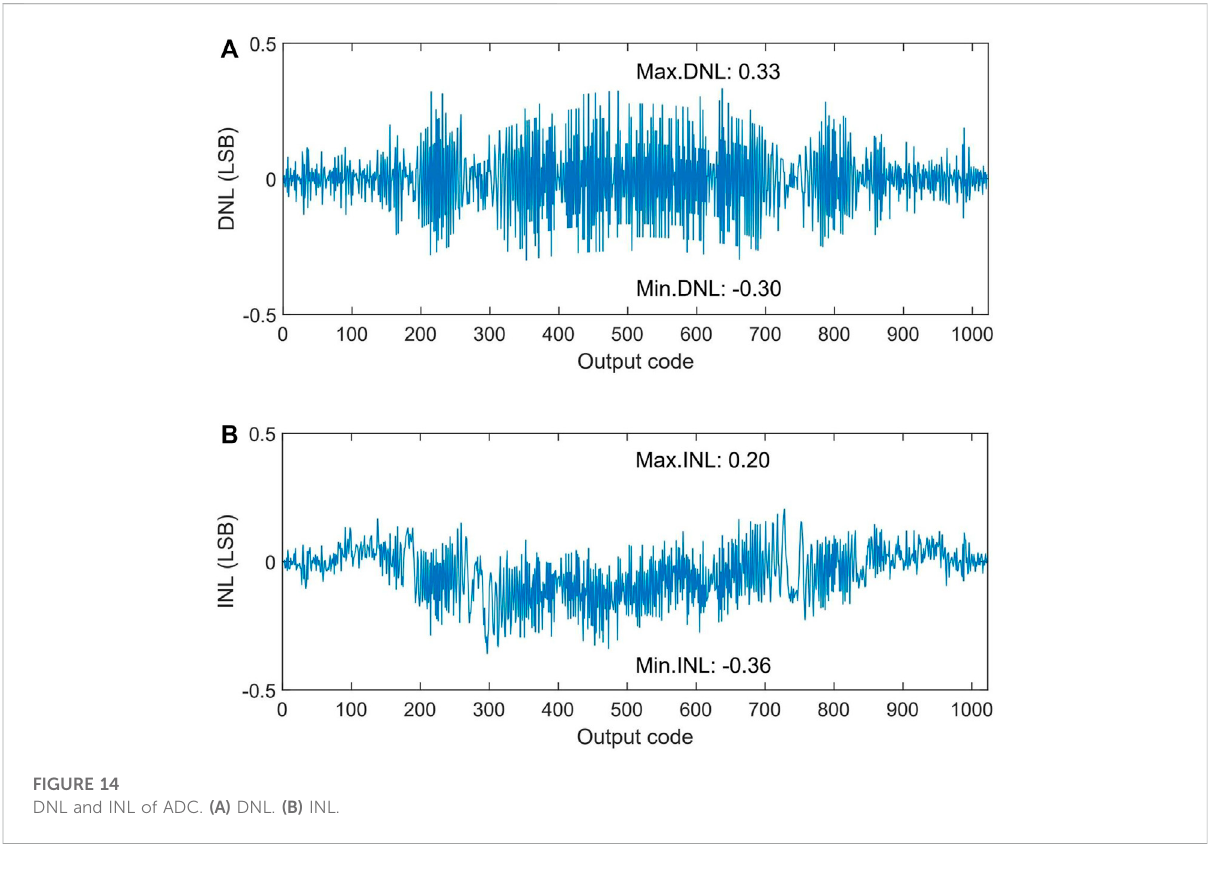
FIGURE 14 DNL and INL of ADC. (A) DNL. (B) INL.